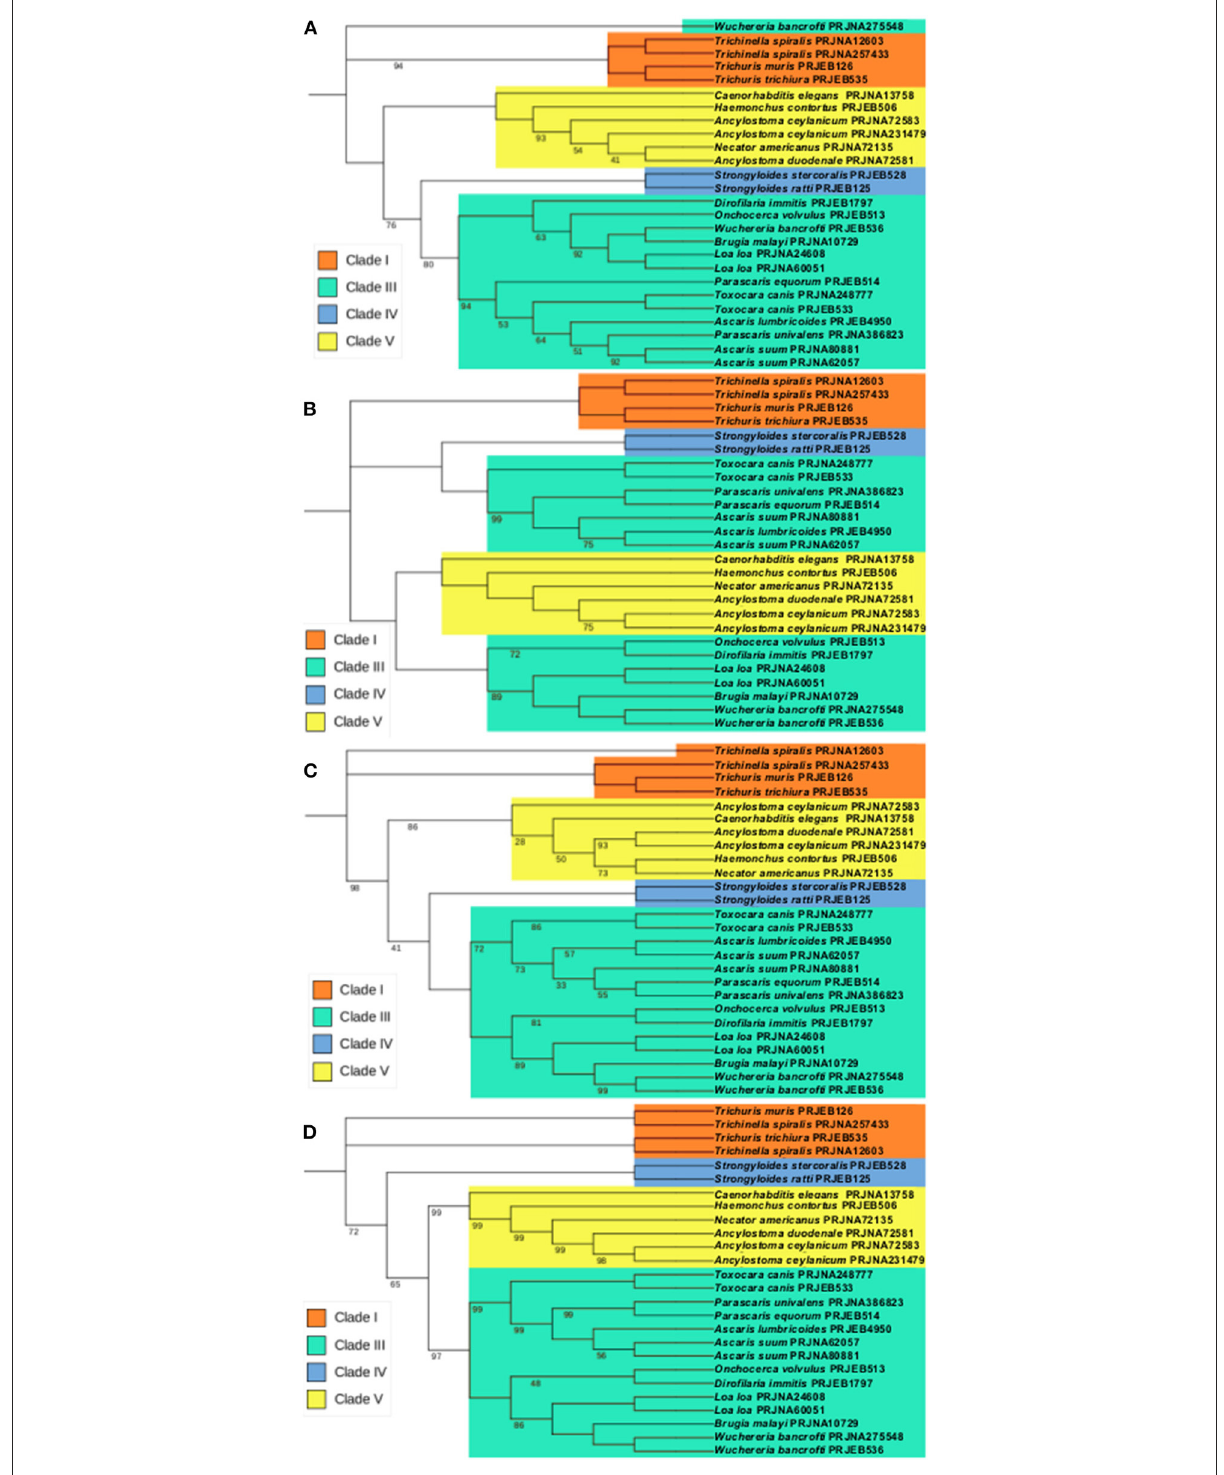
FIGURE4 Maximum likelihood phylogenies using the predicted vaccine targets and orthologs found in other nematodes. The trees were inferred using bootstrap values with 500 replicates. Values on the nodes represent the percentage of bootstrap support values and nodes without bootstrap values were supported by 100% of the 500 replicates. Each sequence is identified by the nematode species followed by the respective BioProject (proteins transcripts used in these analyses are individualized in Supplementary Table 4). (A) Phylogenetic tree of ATtype orthologs.